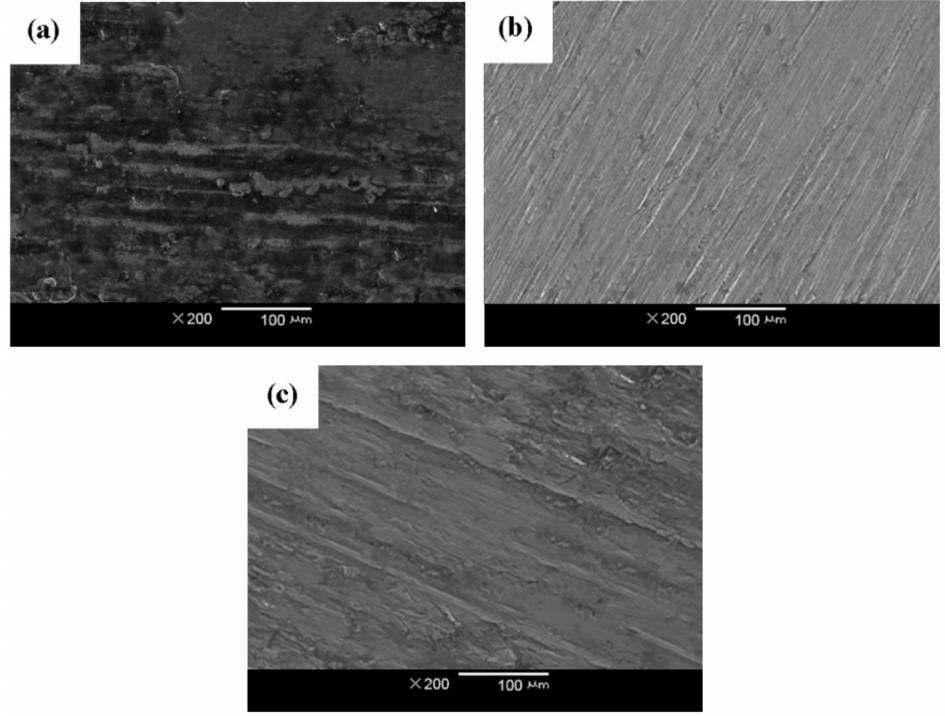
Figure 8. Worn images of Ni/TiN coatings produced at various laser powers: ( a ) 1 kW, ( b ) 1.5 kW, ( c ) 2